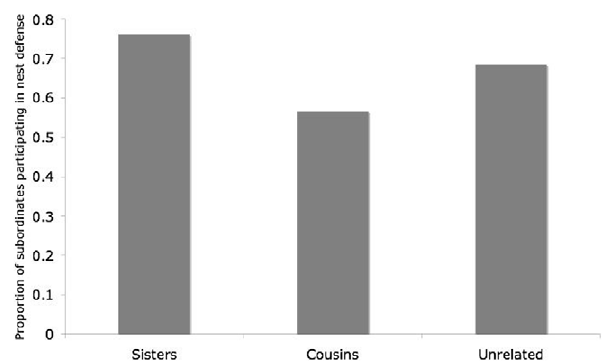
Figure 5. Aggressive responses to a conspecific usurper by sisters, cousins and non-relatives of the dominant.